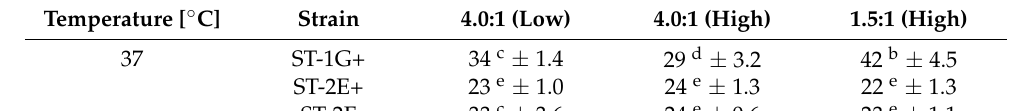
Table 1. Particle size (d V,90 , µ m) of stirred gels after 7 d of cold storage ( n = 4). Gels were produced from base milk with casein:whey protein ratio of 4.0:1 or 1.5:1 by inoculation with low- or high-activity starters and fermentation at a fermentation temperature of 37 ◦ C or 42 ◦ C 1 .